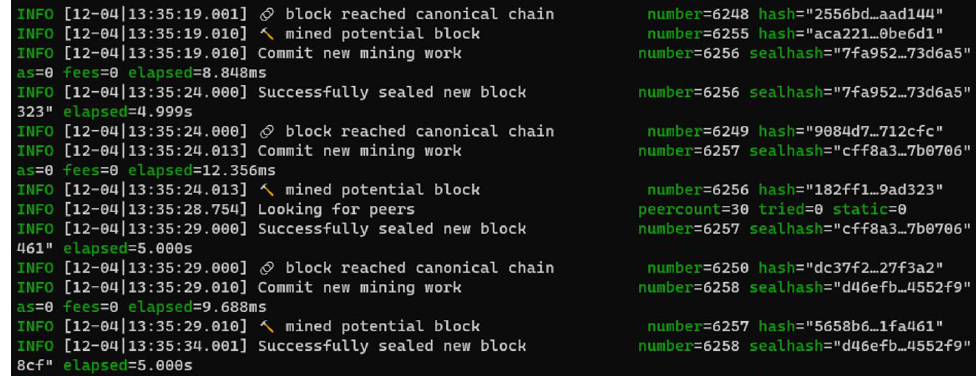
Figure 7. Node initialization.